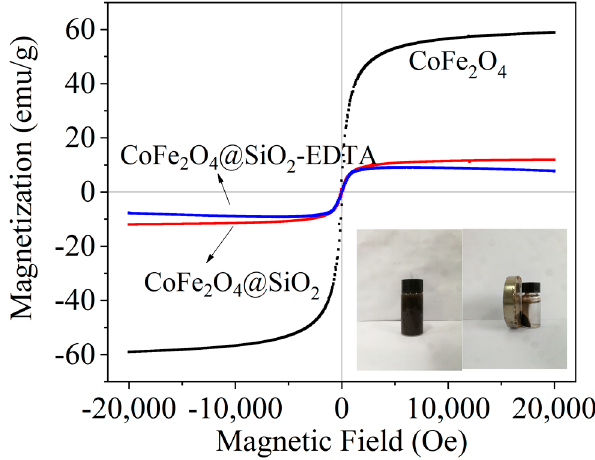
Figure 4. X-ray di ff raction (XRD) patterns ( a ) and FT-IR spectra ( b ). Figure 4. X-ray diffraction (XRD) patterns ( a ) and FT-IR spectra ( b ). Figure 4. X-ray diffraction (XRD) patterns ( a ) and FT-IR spectra ( b ).